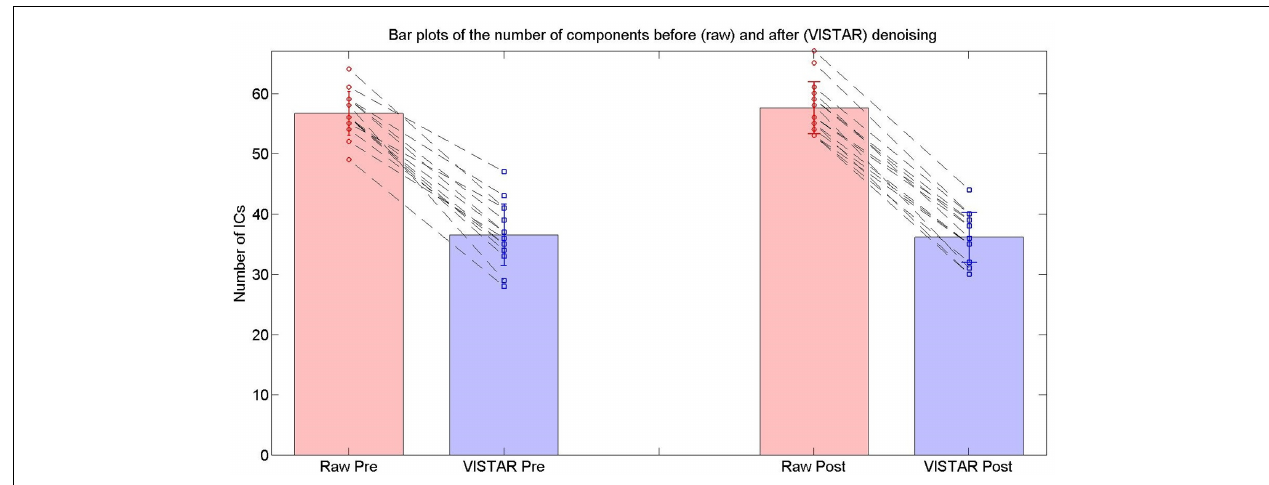
FIGURE 2 | The number of ICs used for the RSN group analyses in the exercise dataset from the Raw andVISTAR pipelines. No significant differences were noted in the number of ICs pre- vs. post- Raw ( p = 0.274), or pre- vs. post-VISTAR ( p = 0.747).